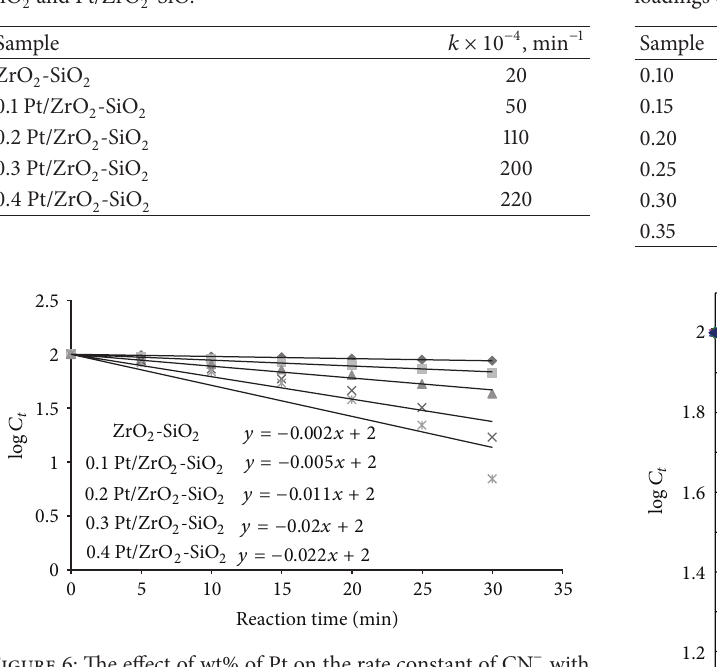
- Table3:ObservedrateconstantsofCN − degradationusingdifferent 2